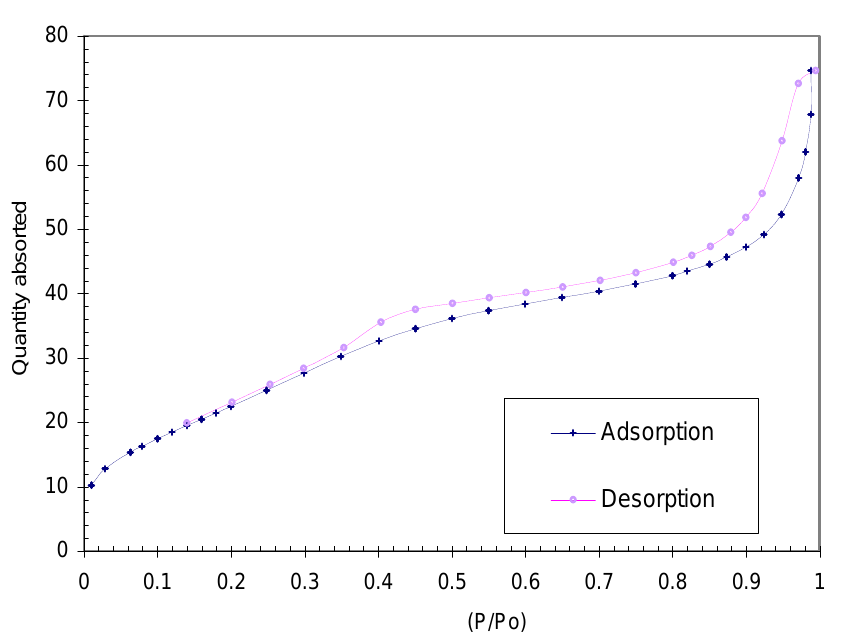
Figure 1. XRD of sulfated zirconia.